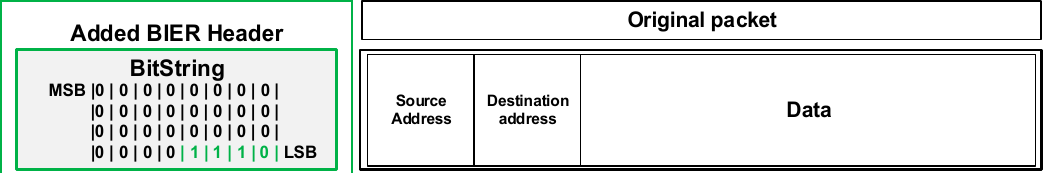
11 of 24 Figure 7. Detection of a failure and the reaction of the B-REP mechanism. The BIER header includes the bit-string (Figure 8) field (BS field), which contains the exact definition of the pre-calculated path along which the packet will be routed (Figure 6). In case of